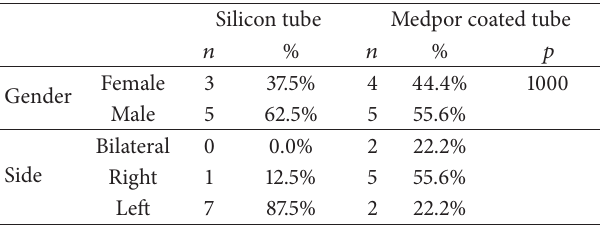
Table 1: Demographic data of patients included in the